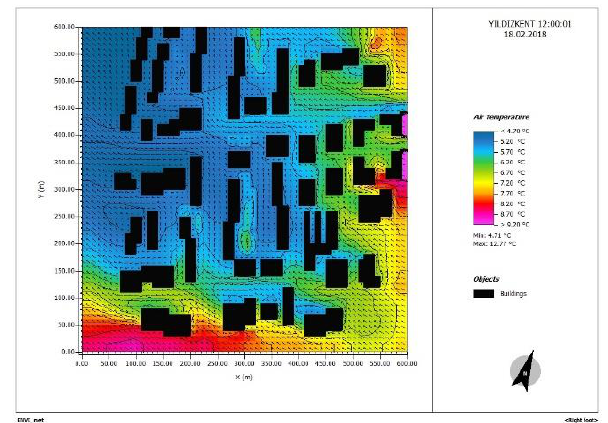
Figure 6. ENVI-met Simulation for Yildizkent